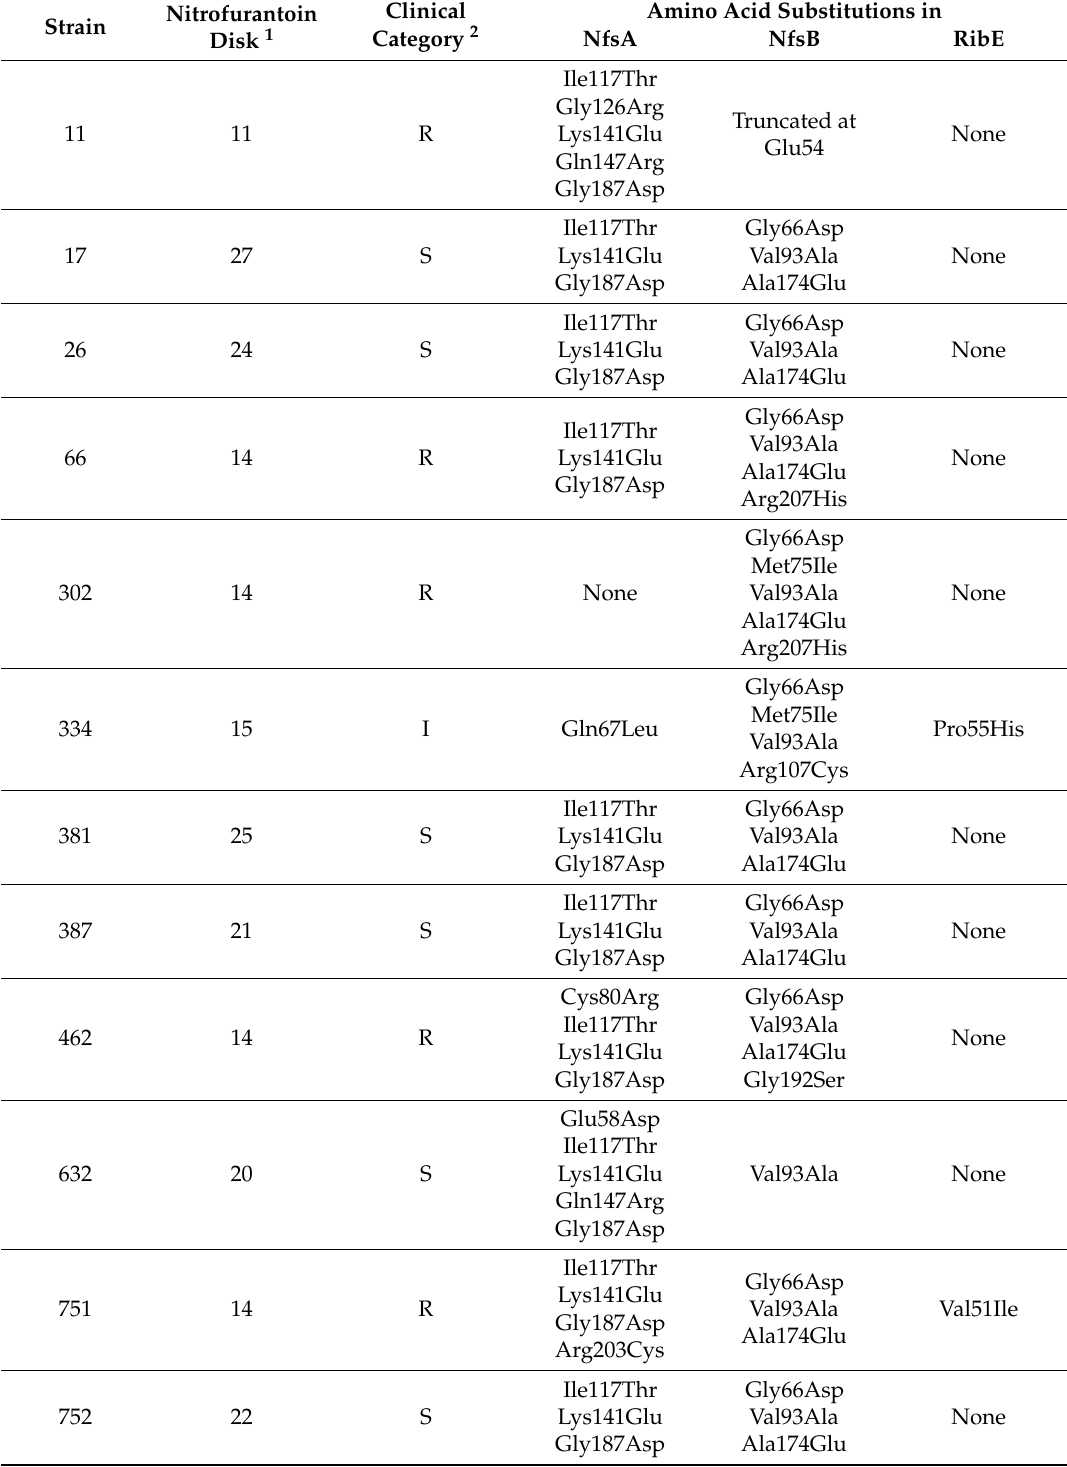
Table 3. Susceptibility to nitrofurantoin according to the Clinical and Laboratory Standards Institute (CLSI) procedure and amino acid substitutions in NfsA, NfsB, or RibE proteins of 29 clinical isolates of Escherichia coli